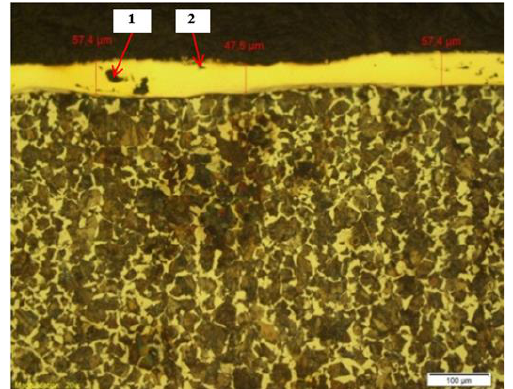
Figure 4. Microstructure of a sample with an electrospark coating of CuAl9Fe3 (CuAl8Fe3) (×200).